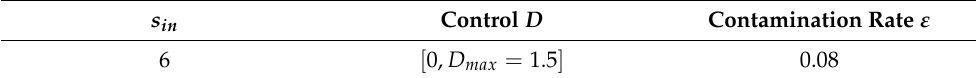
Table 2. Model and OCP settings. The contamination rate ε characterizes the target set T .